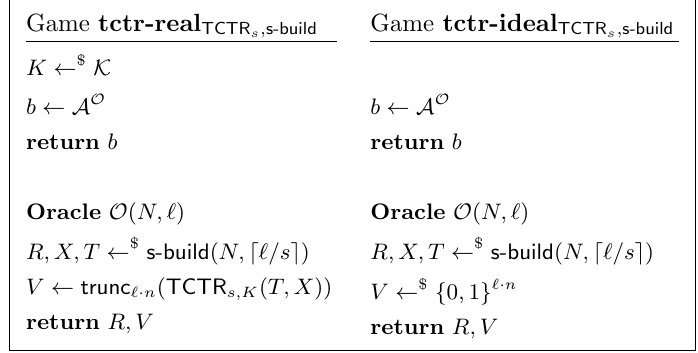
Figure 7: Games tctr-real TCTR